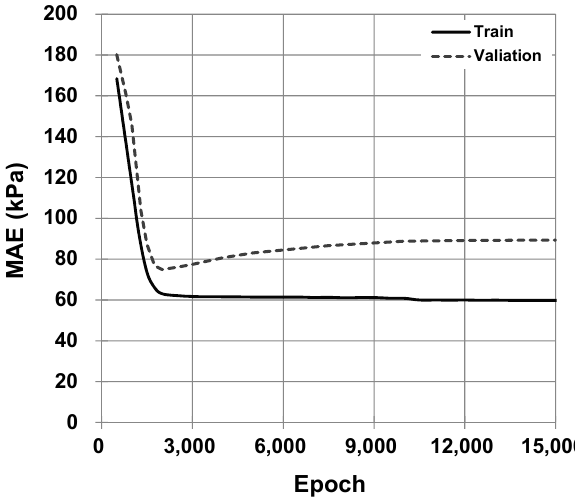
Figure 10. Change in accuracy according to epochs for training and cross-validation (hidden layer = 2, node = 10, batch size = 20).